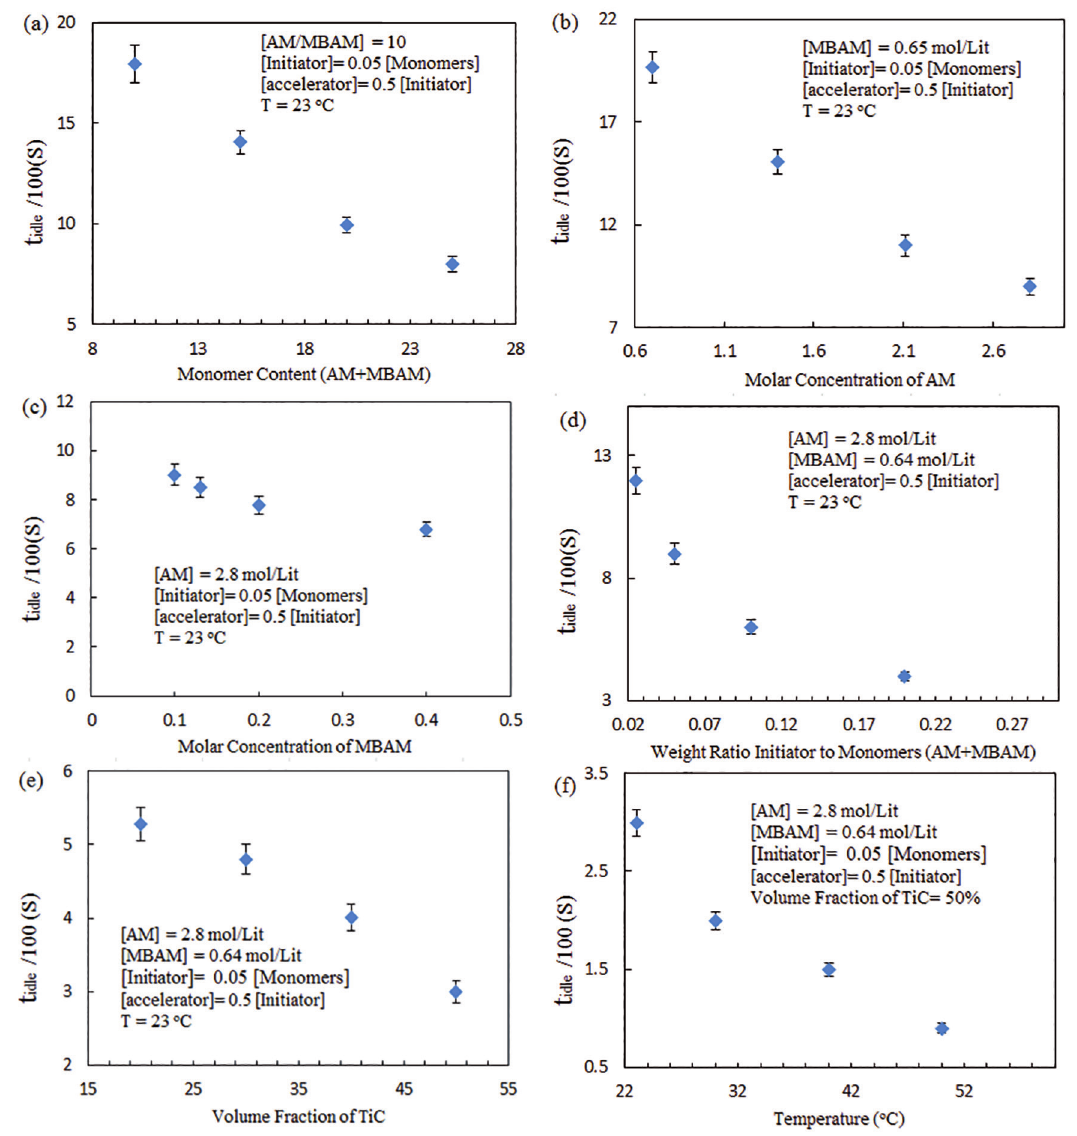
of the pre-mix solution as the function of (a) monomer content, (b) molar concentration of AM, (c) Figure 8: The changes in the t idle molar concentration of MBAM, (d) weight ratio initiator to monomers (AM+MBAM), (e) volume fraction of TiC and (f) temperature.